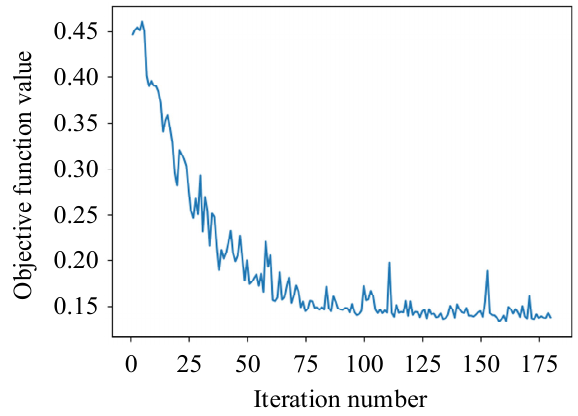
Figure 7. CSI iterative solving process.